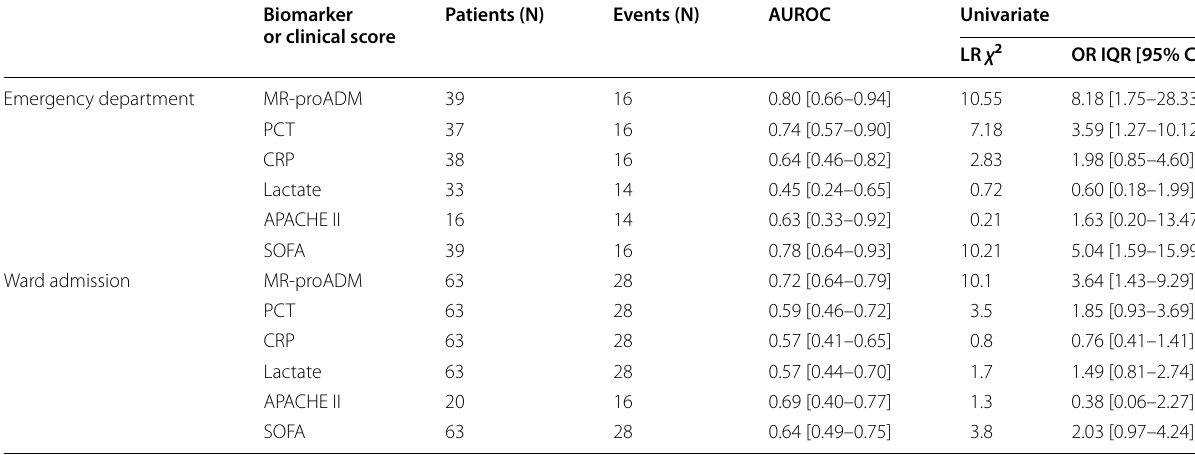
Table 4 Intensive (ICU) and surgical intensive (ICU) care unit admission from the emergency department and ward